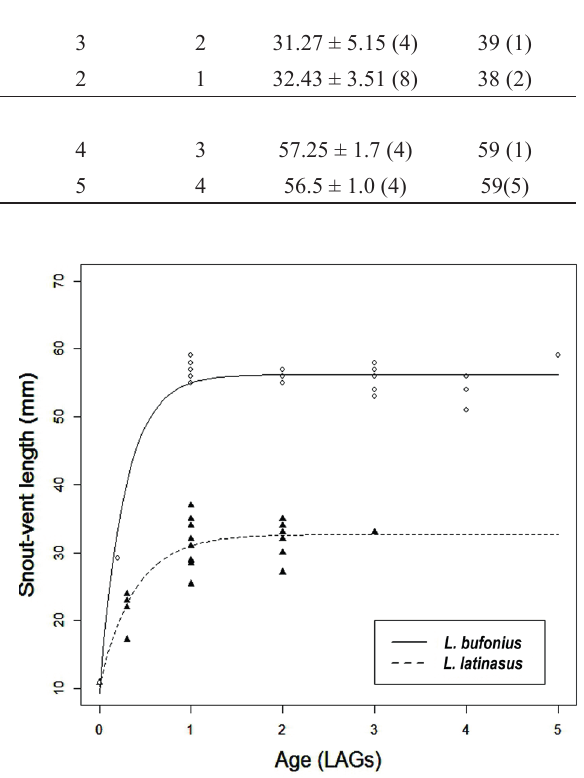
Figure 4 - growth patterns in Leptodactylus latinasus (black triangles) and L. bufonius (open